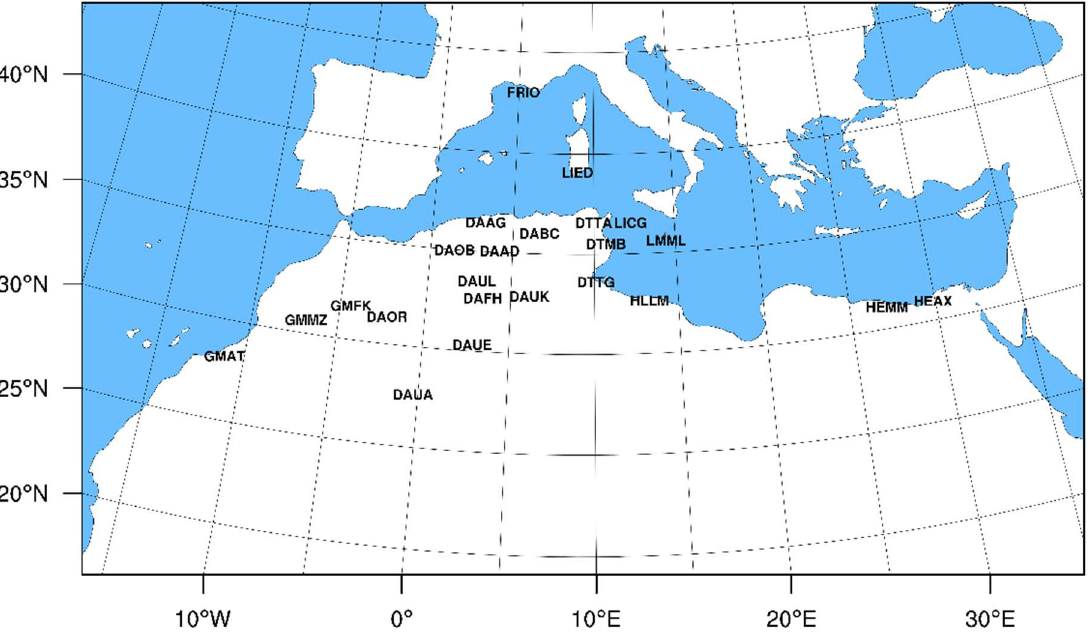
Figure 1. The model domain and the network of meteorological stations in the Northern Sahara and the Mediterranean basin .Although some new land cover classifications have been developed and incorporated in the WRF model [23], by default, the WPS/geogrid program interpolates land use